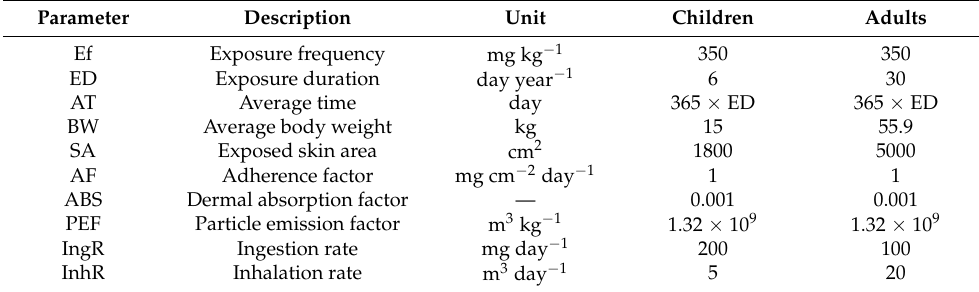
Table 4. Exposure factors used in the health risk assessment.